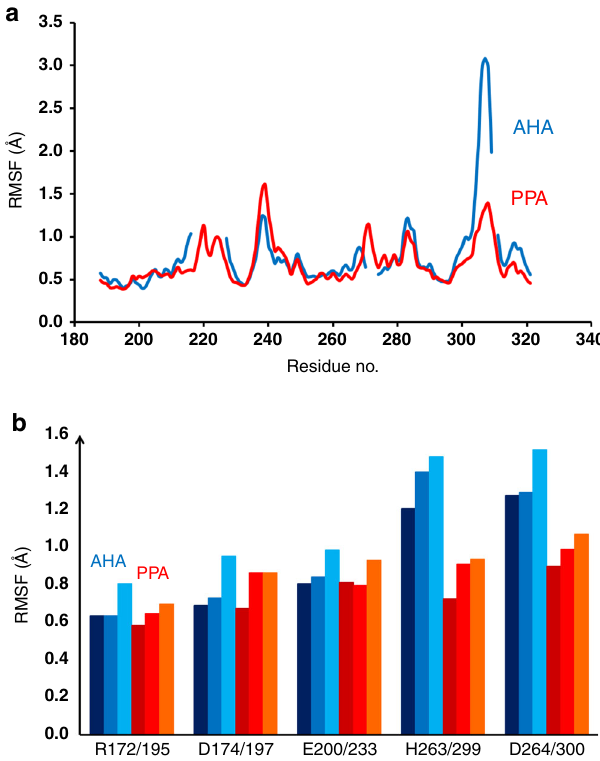
Fig. 4 Mobility differences between the psychrophilic and mesophilic enzymes. a Calculated average backbone positional root-mean-square fl uctuations per residue in the reactant state for AHA (blue) and PPA (red) in the sequence region comprising the active site and L7 loop (PPA residue numbering is used due to sequence insertions). b Average sidechain RMSF for active-site residues at 10, 25, and 40 °C. AHA results are shown in dark, medium, and light blue with increasing temperature and PPA results in a corresponding red